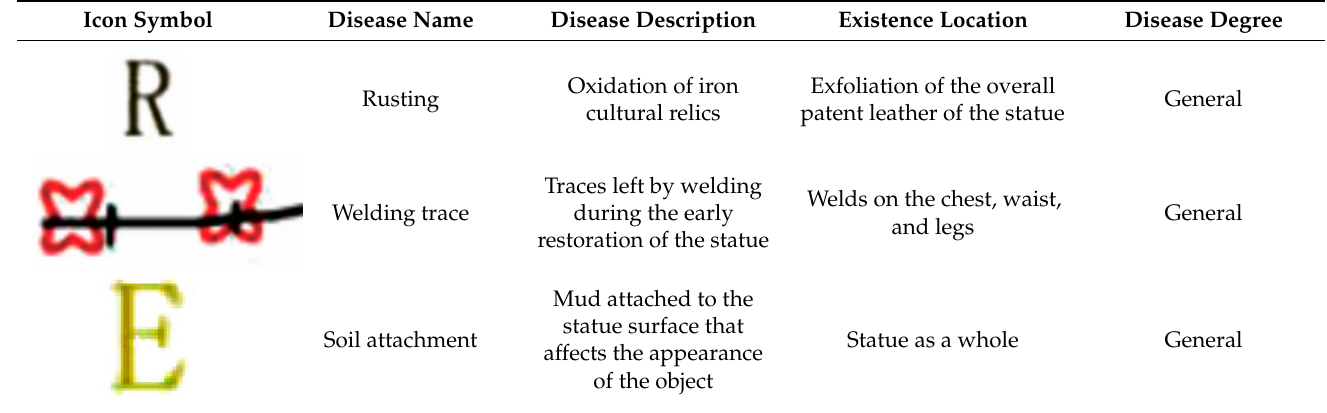
Table 1. Survey of disease status of Chairman Mao Zedong statue.